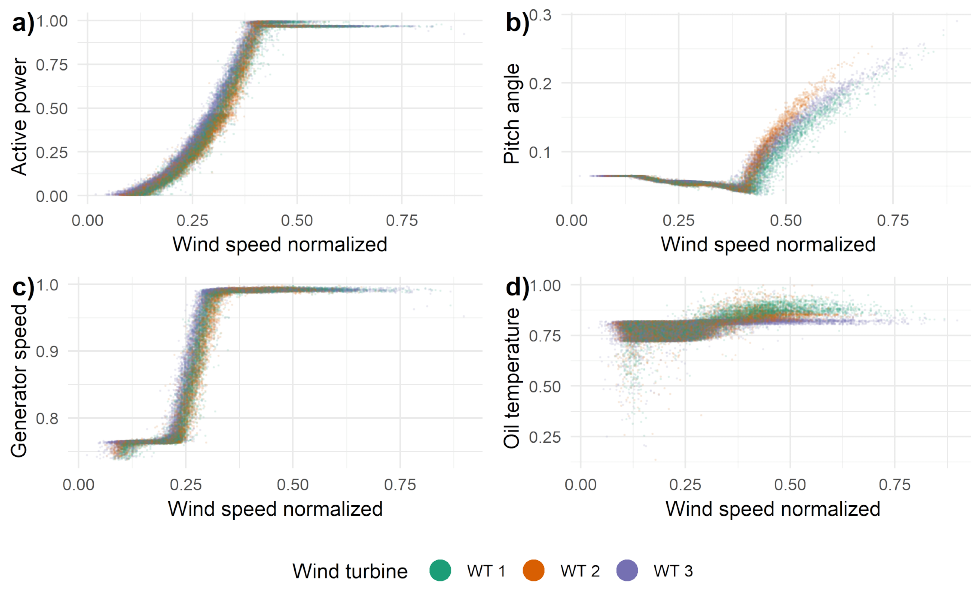
Figure 2. SCADA variables against wind speed by WT. ( a ) Active power against wind speed, ( b ) pitch angle against wind speed, ( c ) generator speed against wind speed and ( d ) oil temperature against wind